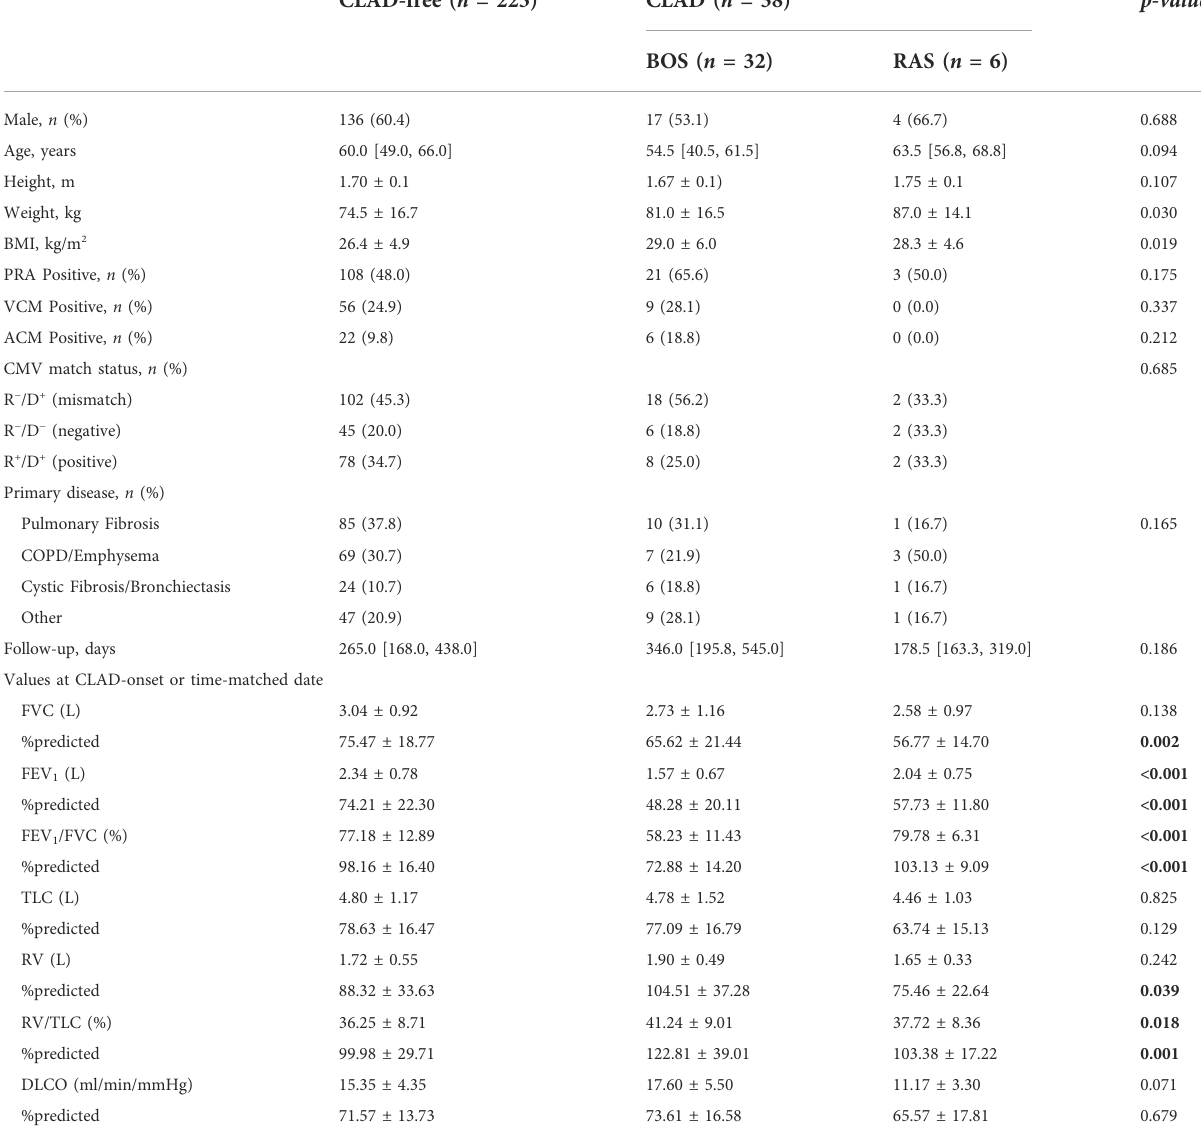
TABLE 1 Demographics and standard pulmonary function of CLAD subjects compared to time matched CLAD-free